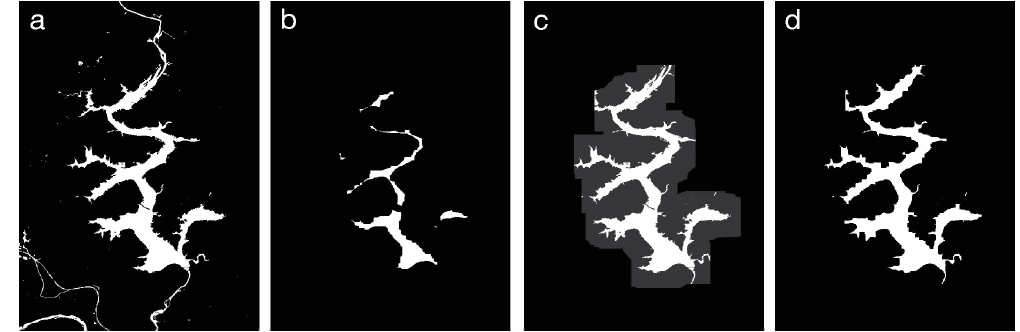
Figure 2. Visualization of the morphological operations used in the automated target detection: ( a ) initial land–water mask, ( b ) after erosion, ( c ) after dilation, ( d ) final land–water